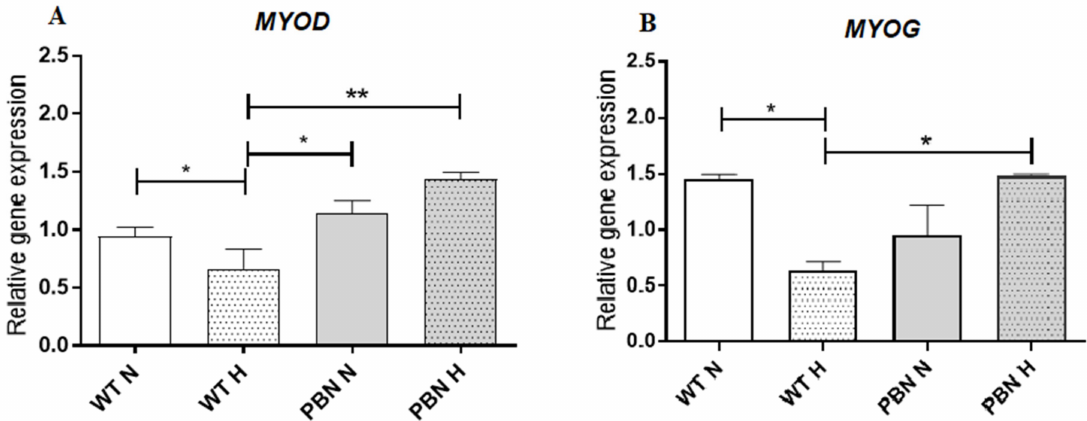
Figure 6. Expression levels of MYOD ( A ) and MYOG ( B ) genes in WT- non-treated myoblast populations and PBN- conditioned ones in standard in vitro (N) and hypoxic (H) in vitro culture conditions. * significant at p value < 0.05, ** significant at p -value <